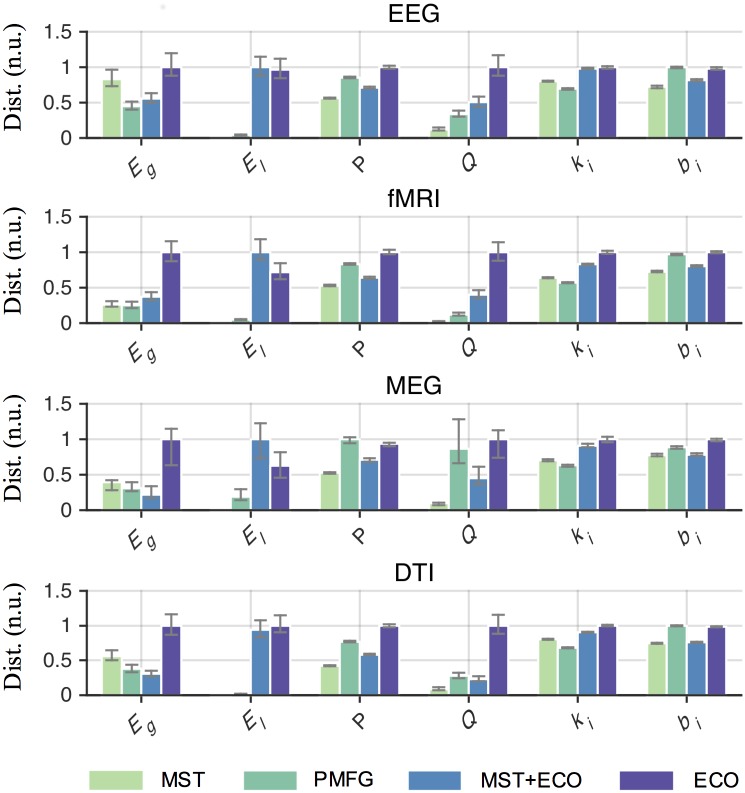
Statistical comparison of brain network distances across filtering methods.Bar plots show the medians of distance between brain network properties of samples in the healthy and diseased group. Vertical bars denote lower and upper quartiles. Medians and quartiles are in normalized units (n.u.) for the sake of representation. Overall, the choice of the filtering method significantly affects distances between samples (Kruskalwallis tests, P < 0.01, S3 Table). For all graph quantities, ECO tends to give significantly larger distances as compared to other methods (Tukey-Kramer post hoc tests, P < 0.05); in some isolated cases, no significant improvements are reported (S4 Table). By construction, MST gives null distances for local-efficiency as there are no triangles in tree-like networks.